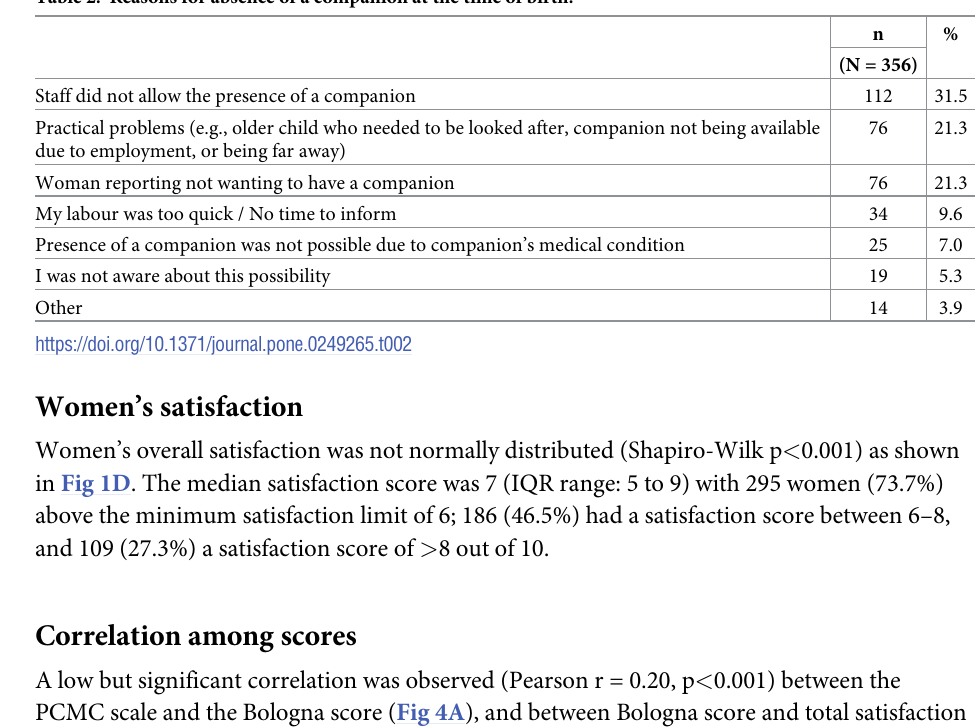
Table 2. Reasons for absence of a companion at the time of